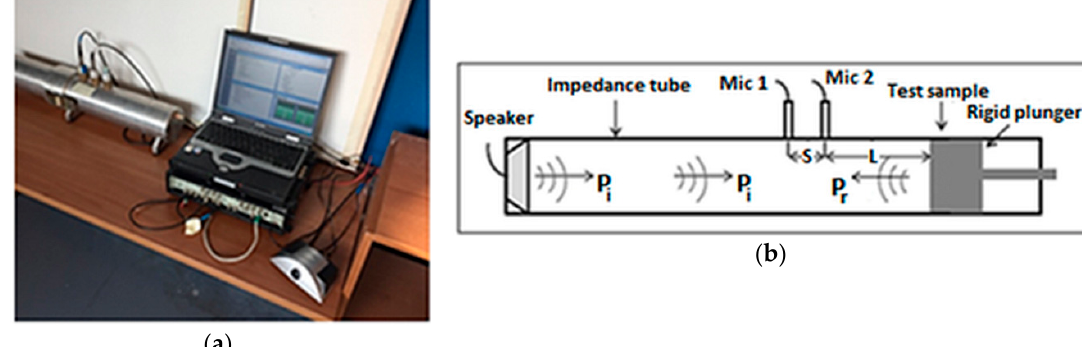
Figure 2. Acoustic sound absorption coefficient measurement. ( a ) Measurement setup in the laboratory; ( b ) Schematic of two-microphone impedance tube method.